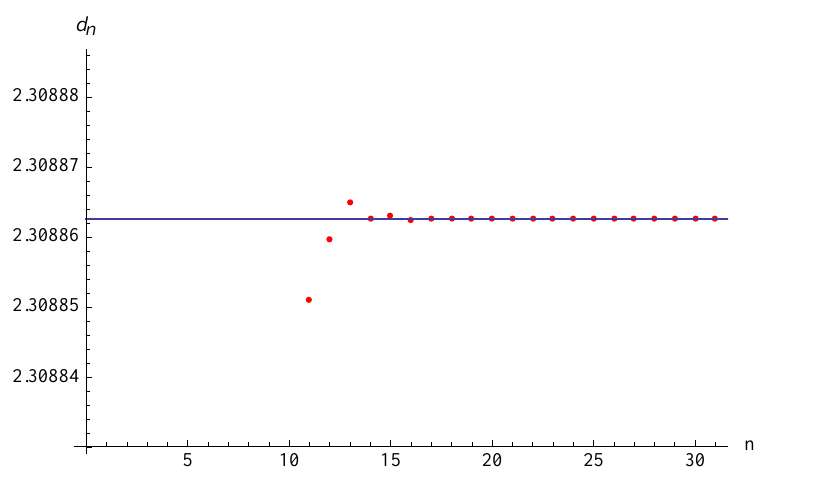
( 1 ) ( 0 ) and their asymptotic form 0, n ( 0 ) = 4 γ (cid:39) 0,1